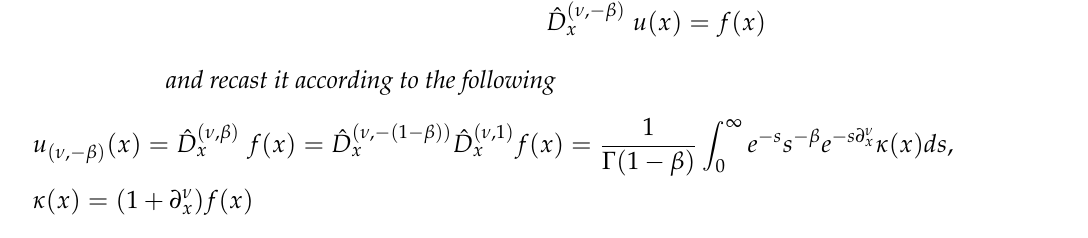
Figure 6. Equation (29) for different values of β , ν = 2 f ( x ) = e − x 8